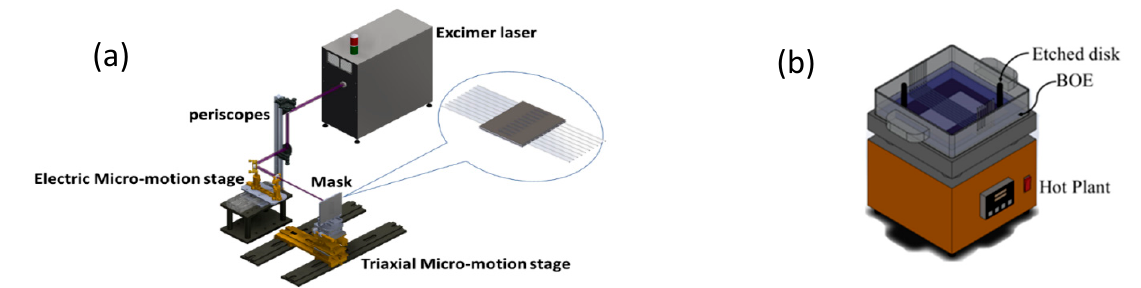
Figure 1. ( a ) KrF excimer laser setup used to assist chemical etching form period structure ( b ) process of chemical etching.